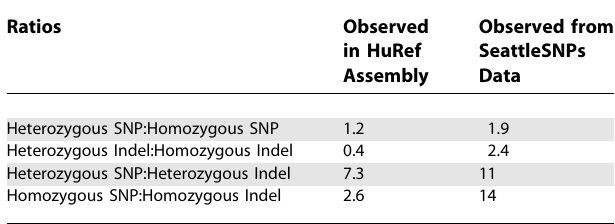
Table 5. Modeling the Occurrence of Heterozygous to Homozygous Variant in a Shotgun Assembly